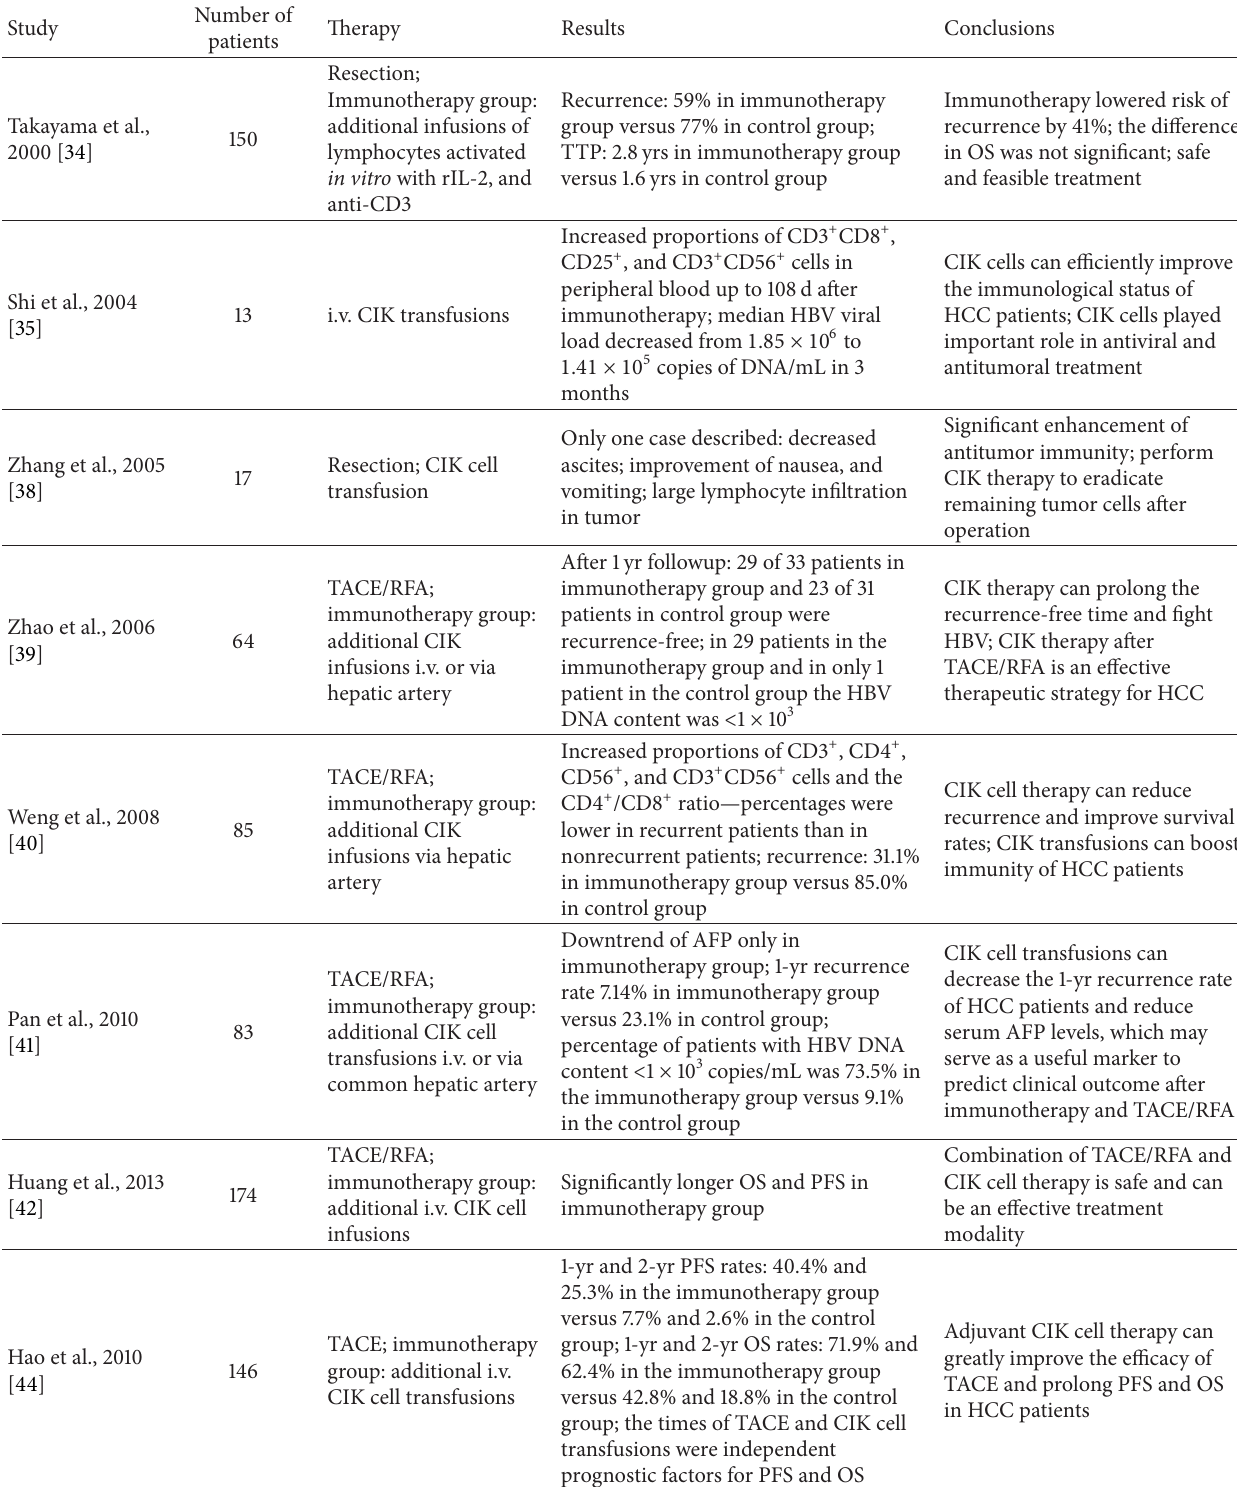
Table 2: Clinical studies applying CIK cells for the treatment of